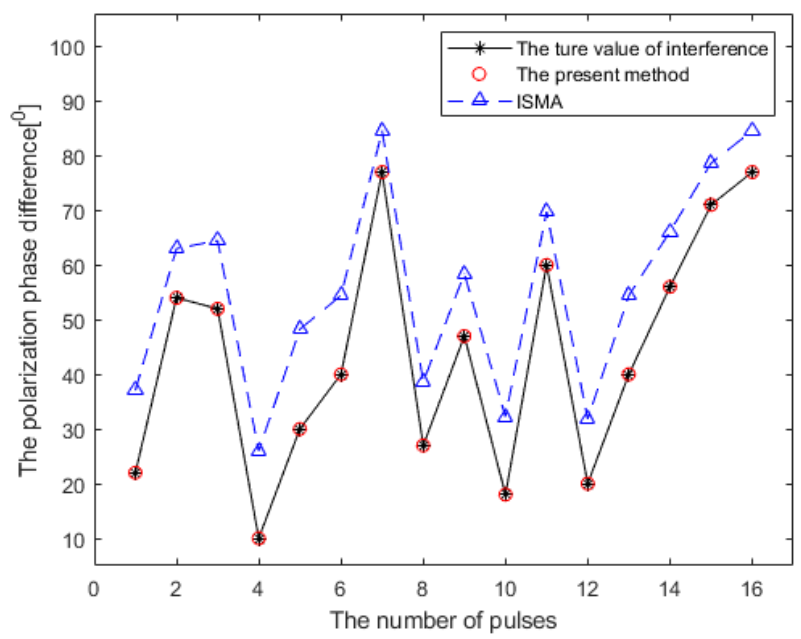
Figure 11. The estimation of these two methods under SNR 2 = − 20